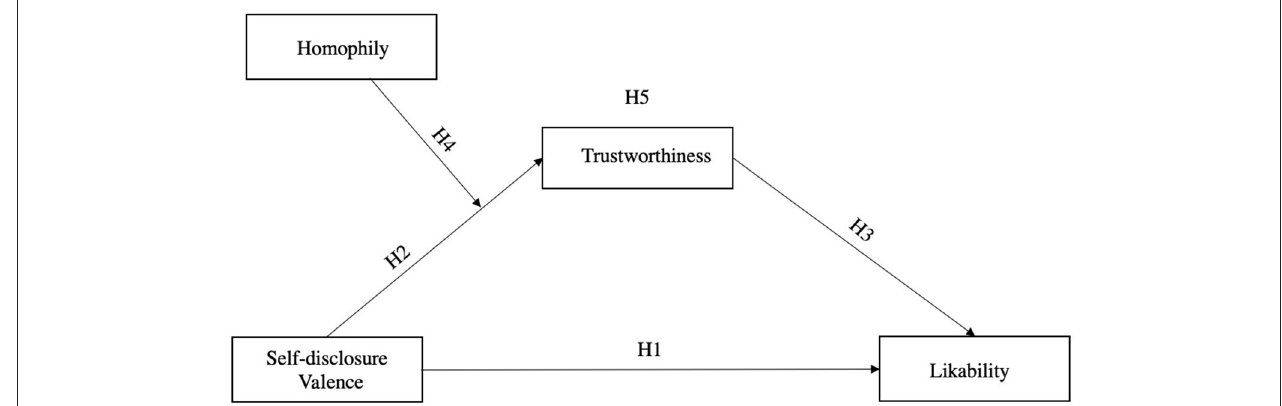
FIGURE 1 | Conceptual